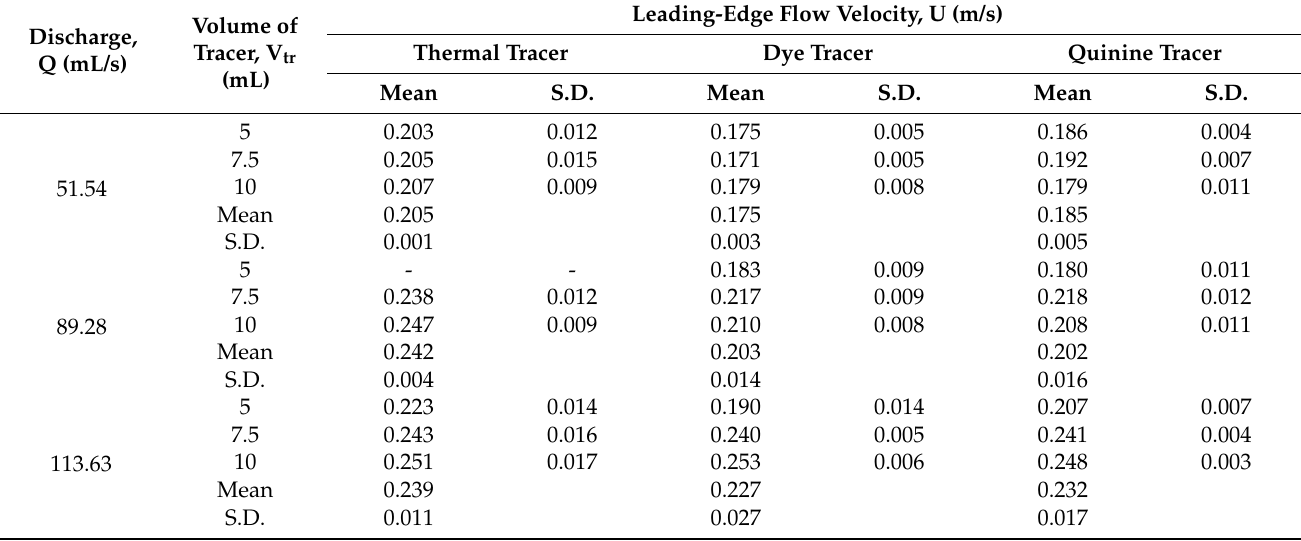
Table 1. Plane surface flow test results for thermal, dye and quinine fluorescent tracer leading-edge velocities, for different discharges and tracer volumes. The data are for three replicates of each combination. Notation “-“ means no data.